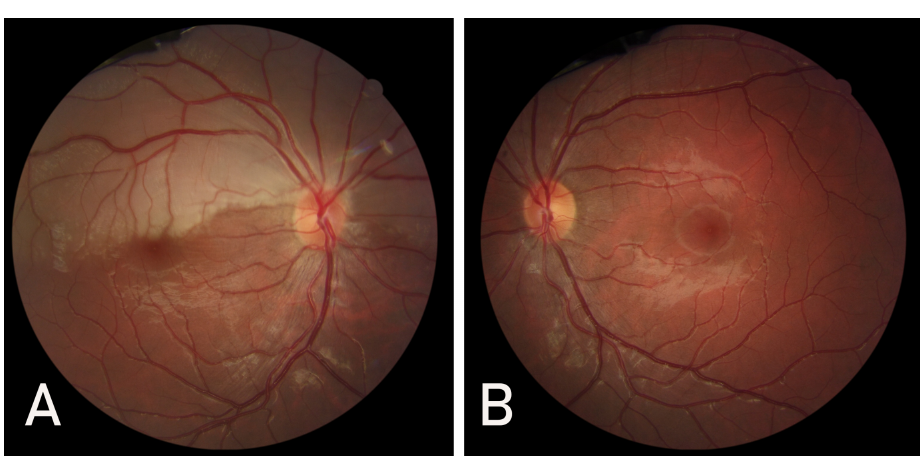
Figure 1: A: A well demarcated superior hemiretinal whitening and foveal sparing in the right eye. B: Normal fundus appearance of the left eye.